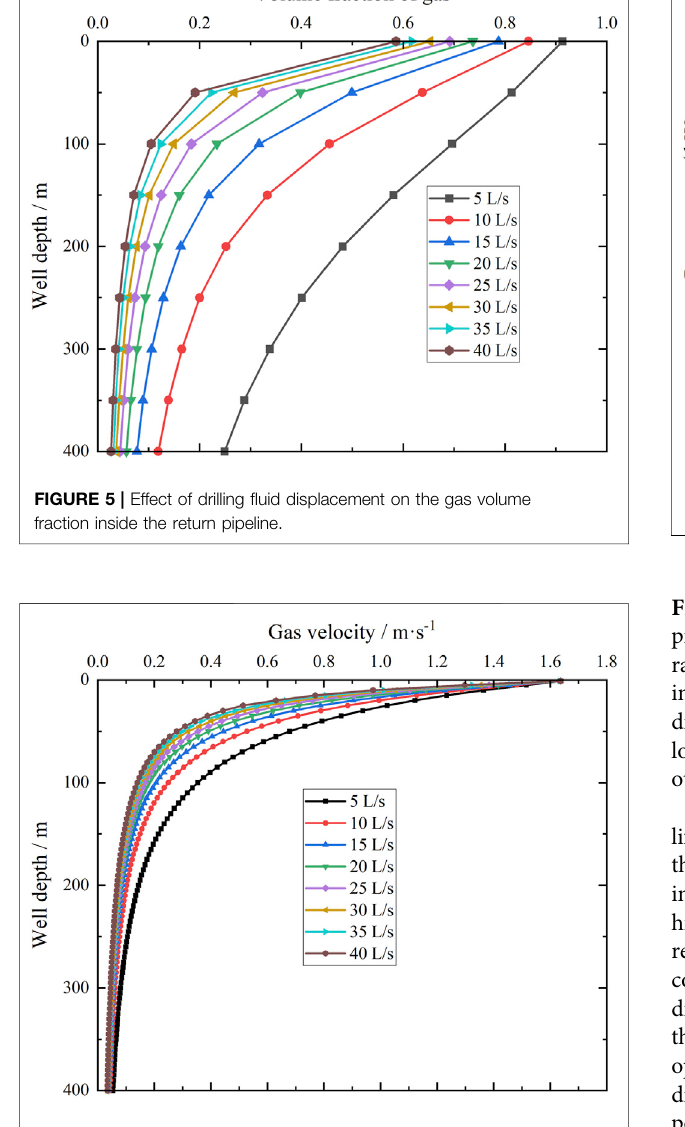
FIGURE 6 | Gas velocity distribution in the wellbore with respect to different drilling fl uid displacements.